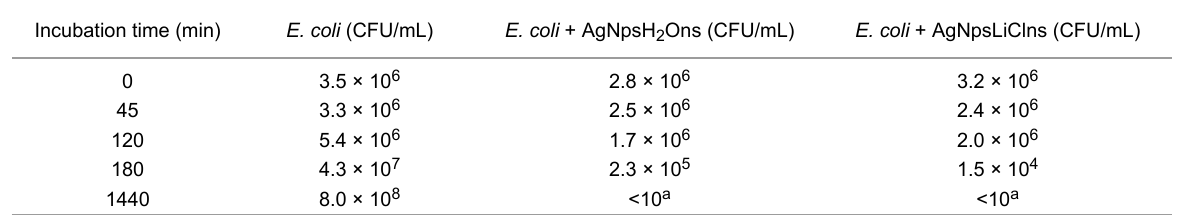
Table 3: Viable count of E. coli cultures grown in microtiter plates in the absence and in the presence of AgNPs (MBC value) at different incubation times. Incubation time (min)